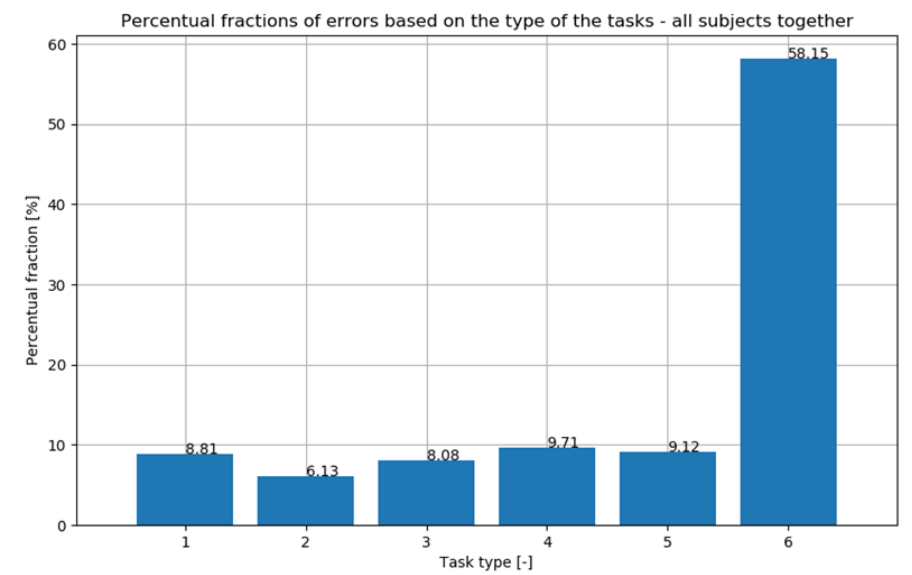
Figure 15. Percentage fraction of errors based on the type of tasks — all subject together.